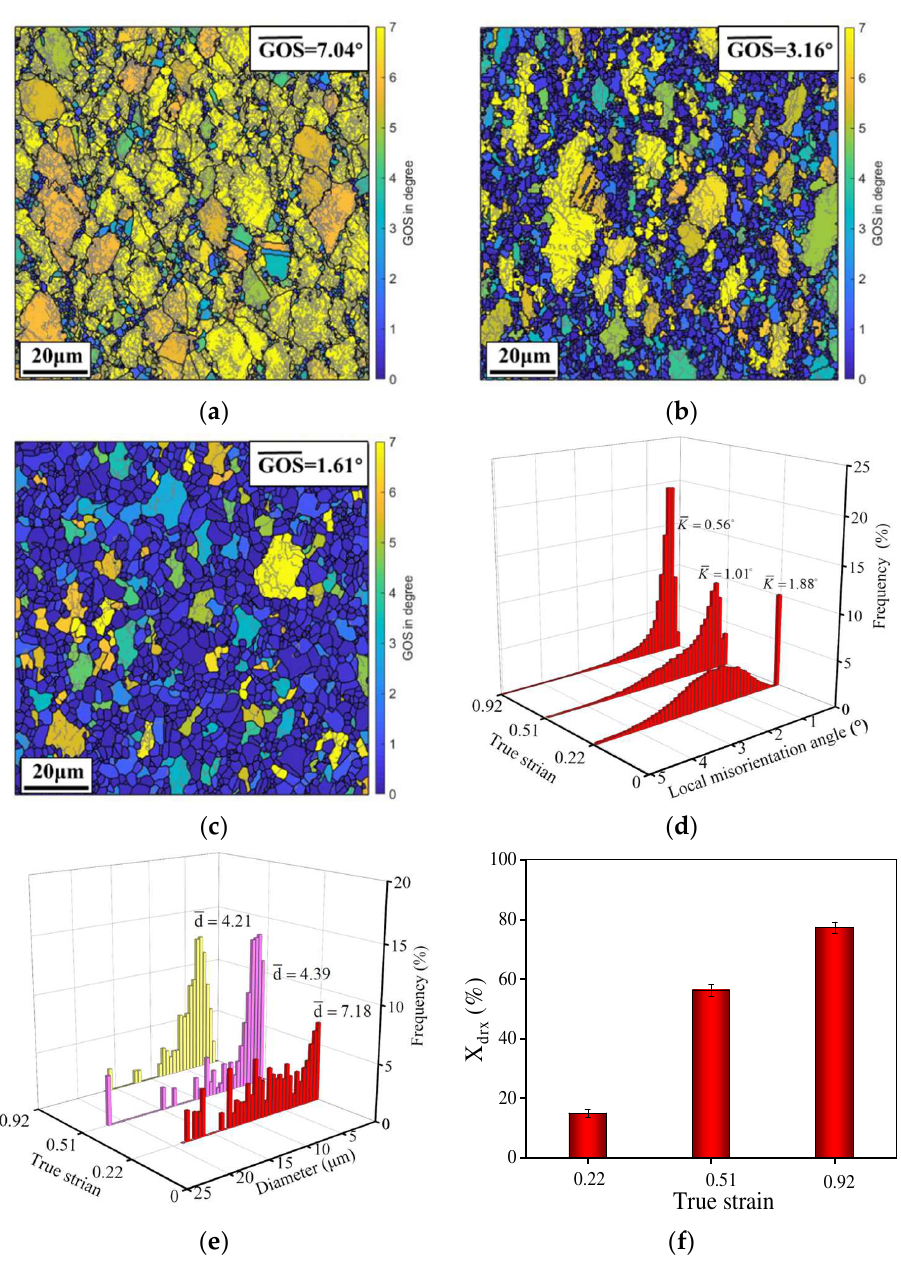
Figure 4. GOS maps of the HIPed superalloy deformed at the true strain of ( a ) 0.22; ( b ) 0.51; ( c ) 0.92 [28]; ( d ) the local misorientation angle; ( e ) average grain size distribution; ( f ) area fraction of DRX (HAGBs and LAGBs correspond to the black line and gray line, respectively. The temperature and strain rate are 1110 °C and 0.1 s −1 , respectively).